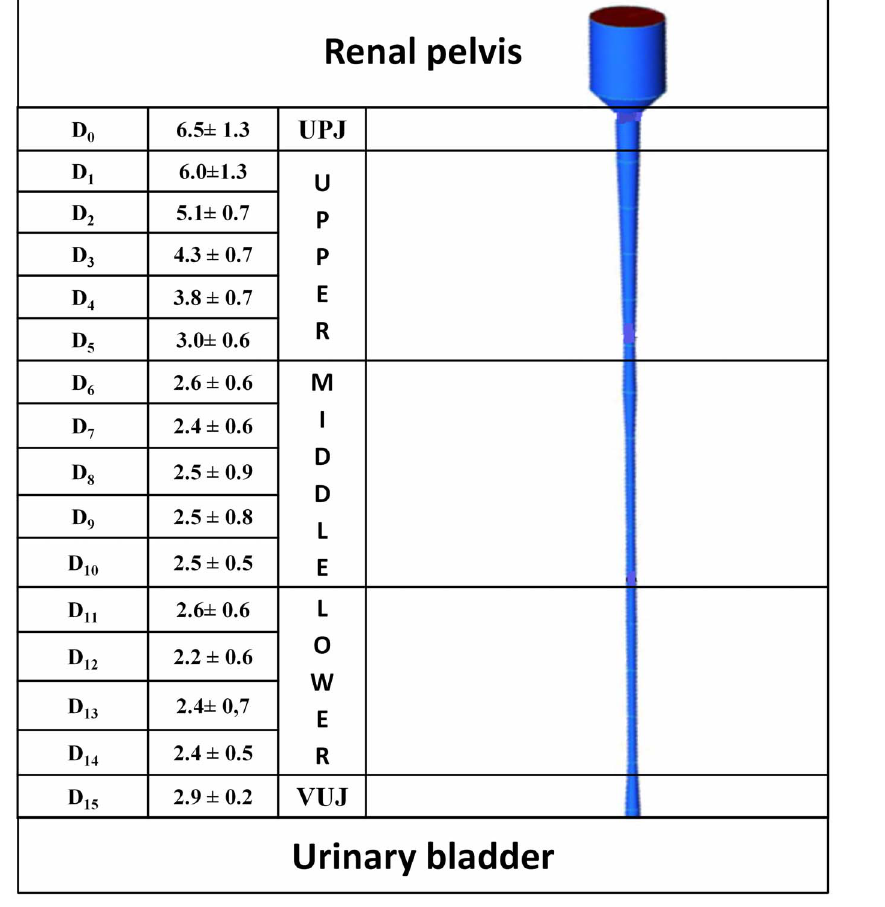
Figure 4. Reconstruction of pig ureter geometry. Average pig ureter internal diameters ( D i , in mm; N=8), along the longitudinal coordinate i ( i =0 at UP; i =15 at VUJ) classified in Upper, Middle and Lower ureter (left). UPJ=ureteropelvic junction, VUJ=vesicoureteric junction. On the right, computer-aided design of the ureter employed as an input geometry for 3D printing.